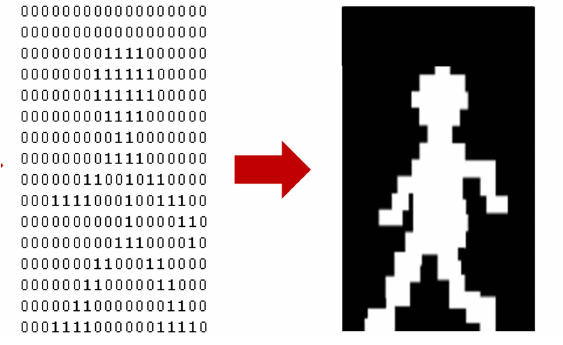
Figure 2. Resulting binary matrix data and silhouette from an object passing through the N-IR beams of a vertical array profiling sensor.